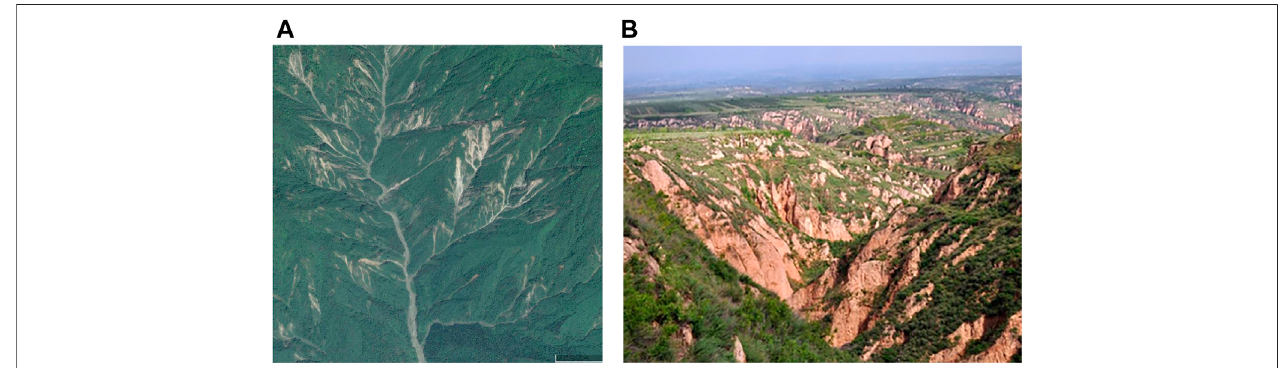
FIGURE 1 | (A) Catchment with water erosion at the Baisha River Basin in Dujiangyan, Sichuan, China; (B) gravity erosion